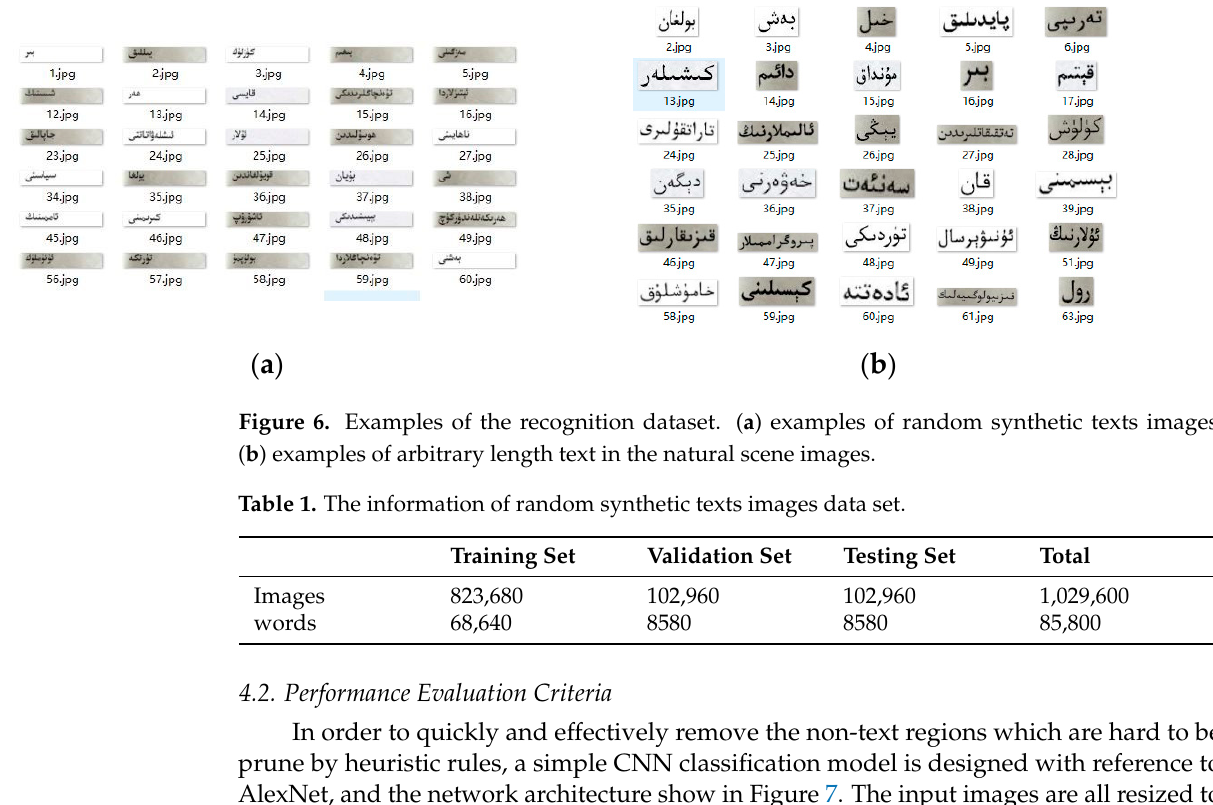
Figure 6. Examples of the recognition dataset. ( a ) examples of random synthetic texts images; ( b ) examples of arbitrary length text in the natural scene images.